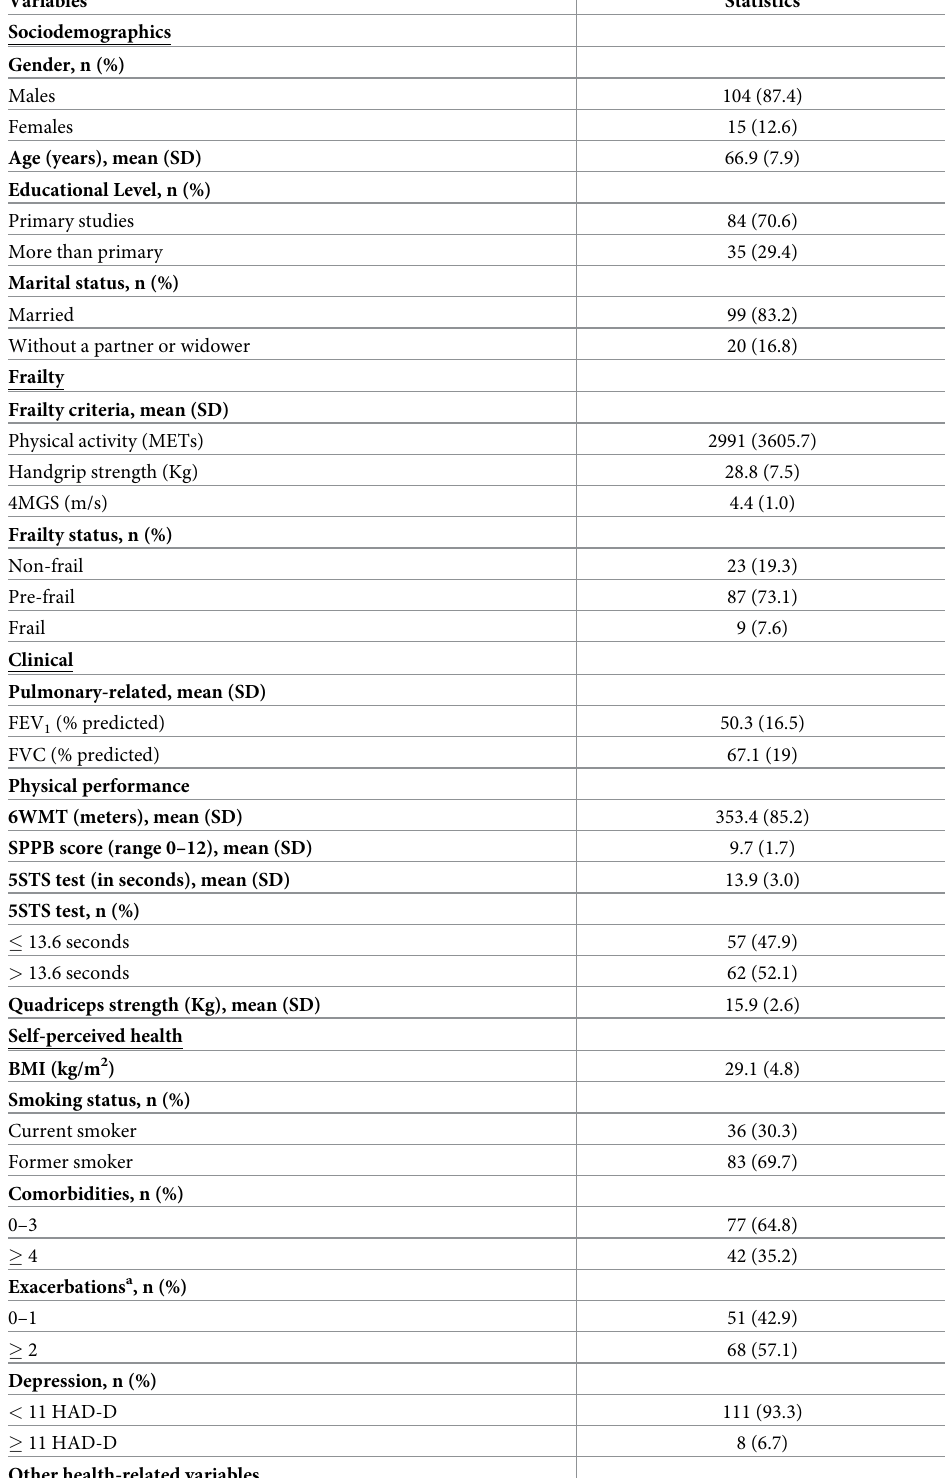
Table 1. Baseline characteristics of participants